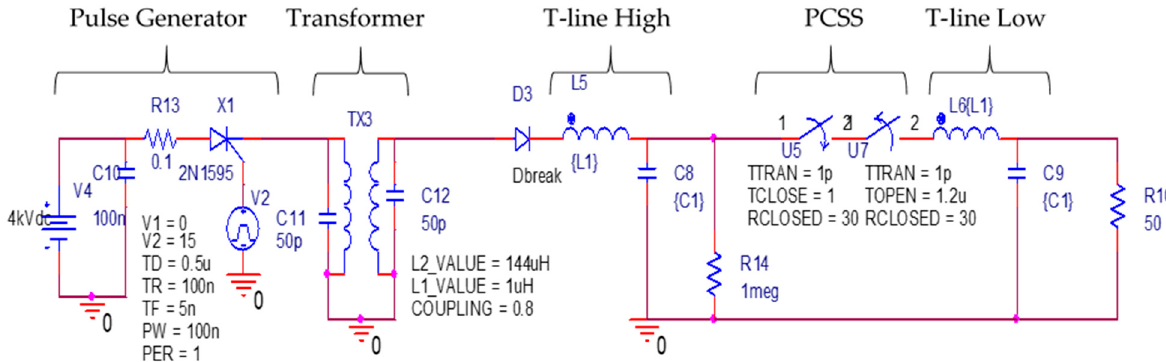
Figure 1. Electrical schematic diagram of pulse charging PCSS testbed (PCB). C10—energy storage capacitor, R13—current limiting resistor, X1—thyristor switch, TX3—step-up transformer with estimated parasitic capacitances C11, C12; L1— parasitic inductance; C8—pulse charged capacitance; R14—bleed resistor; U5, U7—behavior model of PCSS (closing and opening switch action); C9—parasitic load capacitance; R10—50 Ohm resistive load.